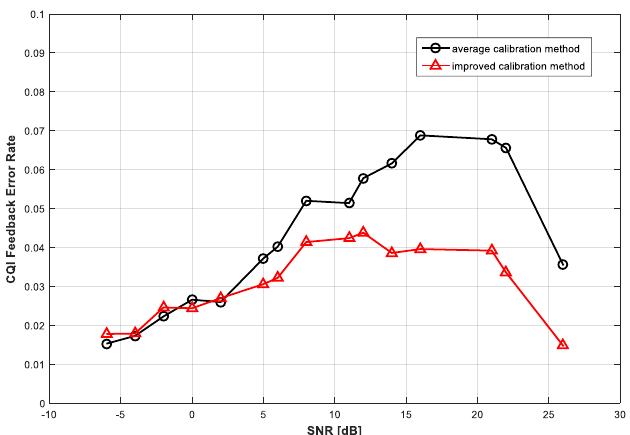
Figure 3. Comparison of CQI feedback error rates for the calibration factors derived from the average calibration method and the improved calibration method.